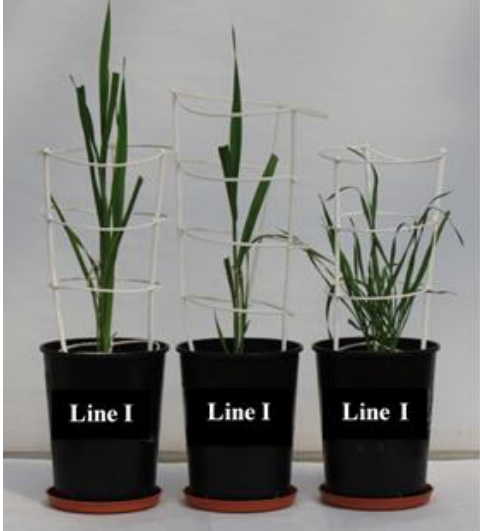
Figure 10. Morphological diversity of the hybrid line I.